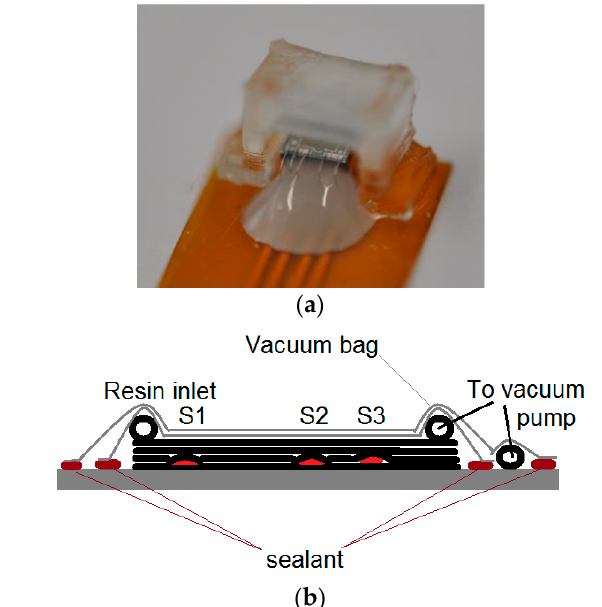
Figure 1. ( a ) A piezoresistive pressure sensor wire bonded on a Kapton PCB; ( b ) A schematic of 3 piezo resistive pressure sensors on bottom layer of 4 plies